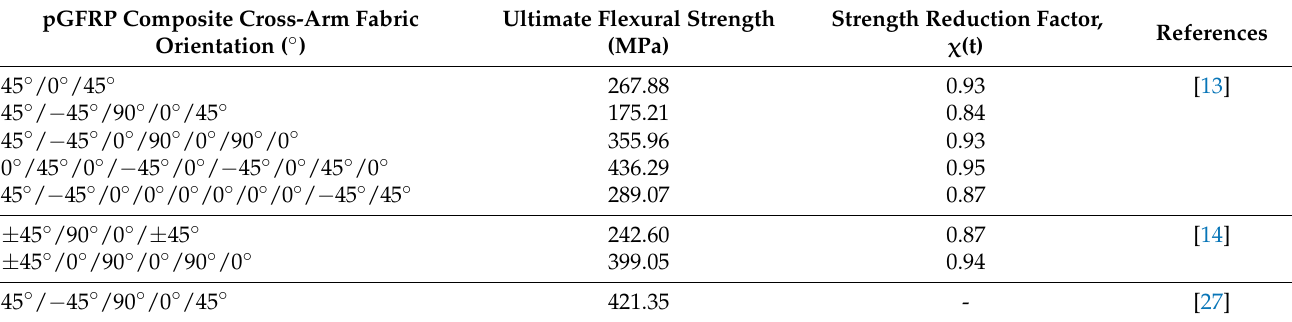
Table 1. Fibre orientation and thickness of glass fibre composite cross